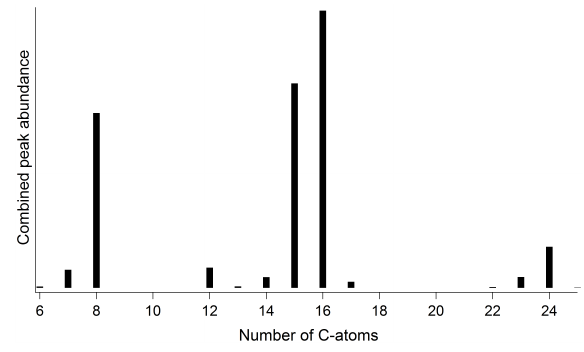
Figure 6. Distribution of the number of C atoms in the indole SOA compounds detected in both positive and negative ion modes by